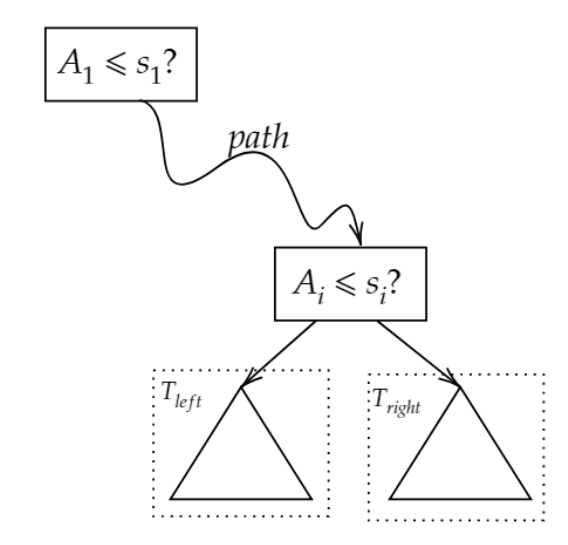
Figure 5. Partial derivative of an internal node.